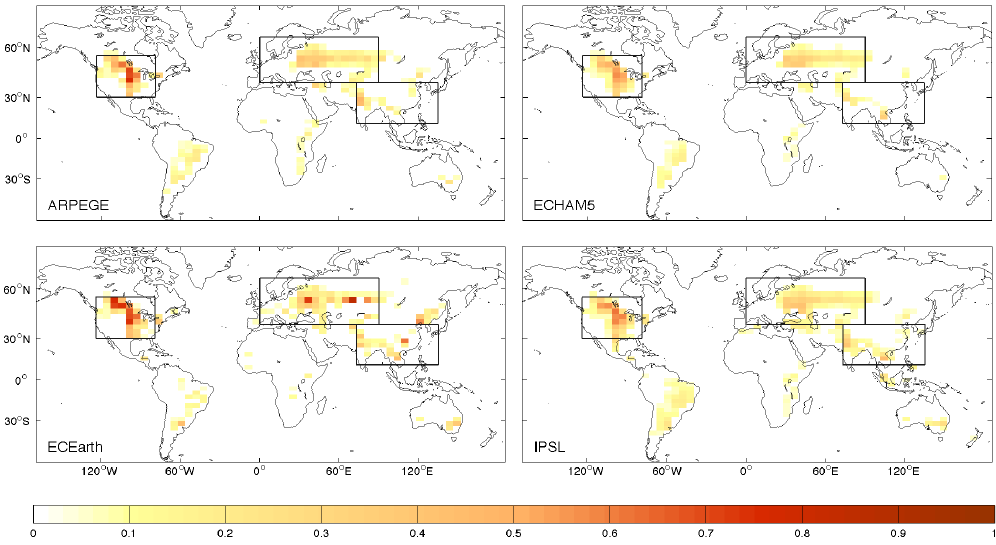
Fig. 1. Fraction of vegetation cover converted from natural vegetation to cropland for the four models. The boxes on each panel outline the regions of intense LULCC used for the scatter plots (North America, 30–55°N, 78–123 ◦ W; Eurasia, 40–65 ◦ N, 0–90 ◦ E; and South East Asia, 11–40 ◦ N, 73–135 ◦